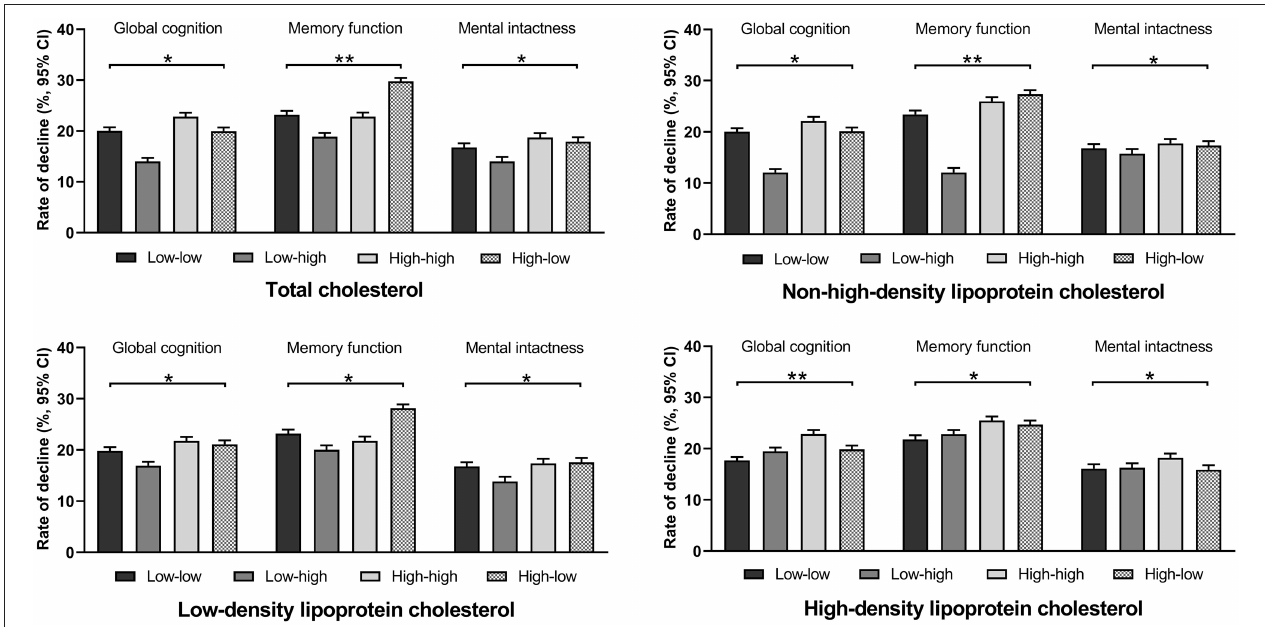
FIGURE 2 | Incidence rate of cognitive decline among cholesterol groups. * P > 0.05; ** P < 0.05.